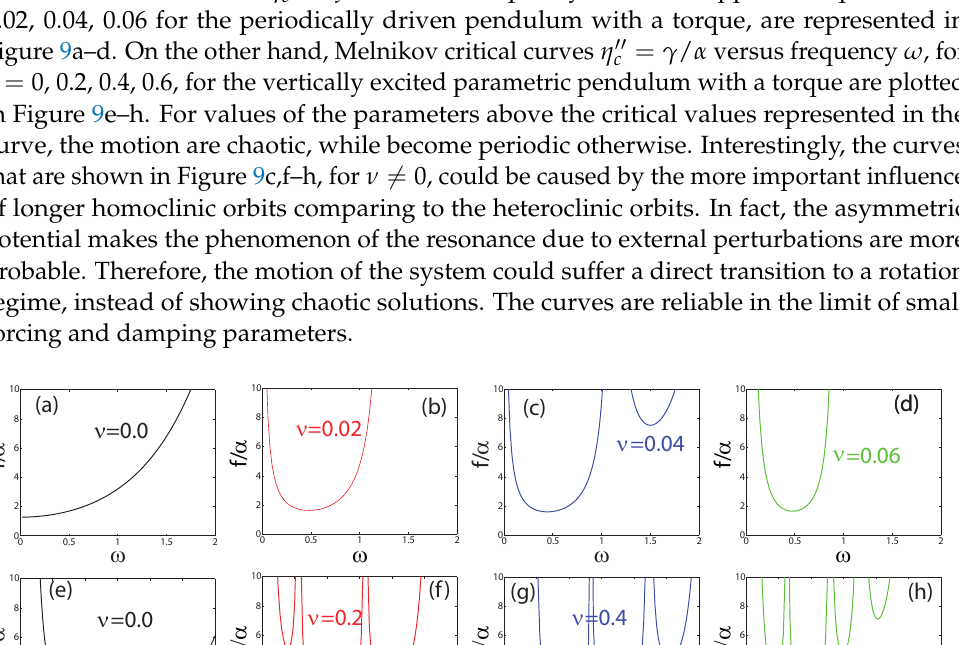
ν = 0, 0.2, 0.4, 0.6, for the vertically excited parametric pendulum with a torque are plotted